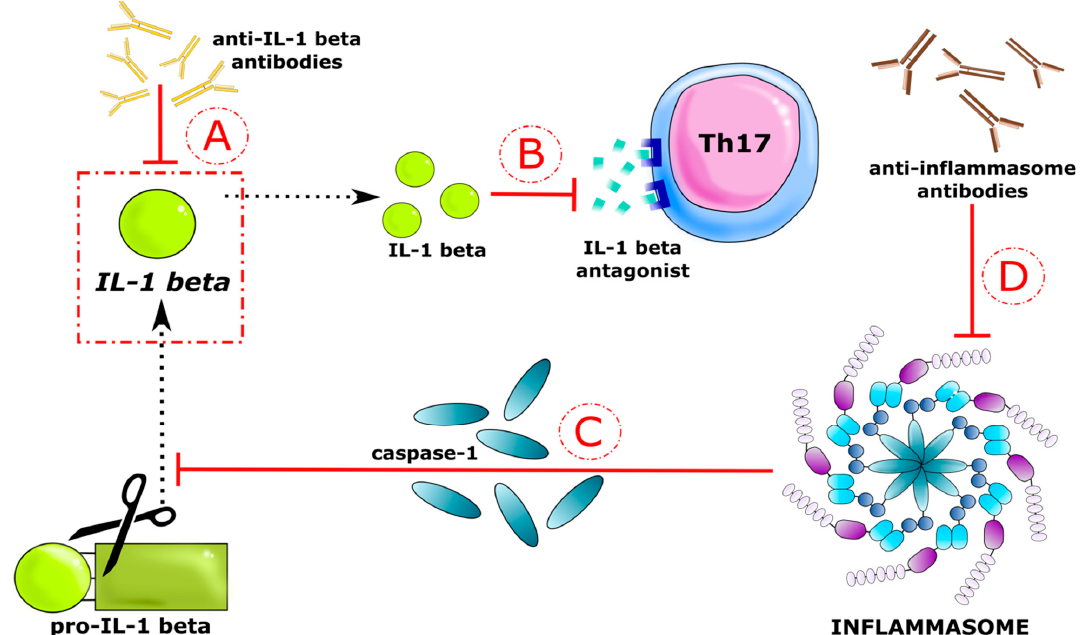
Figure 7. IL-1 beta as a therapeutic target in reducing the allergic inflammatory response. The red arrows represent the likely therapeutic impact sites. IL-1 beta is a highly pro-inflammatory cytokine that has been found to increase in children with IgE-mediated food allergy (FA) and atopic dermatitis (AD). IL-1 beta secreted by cells in an inactive form as pro-IL-1 beta is activated by caspase-1 released from the inflammasome. It acts through two receptors to trigger the polarization